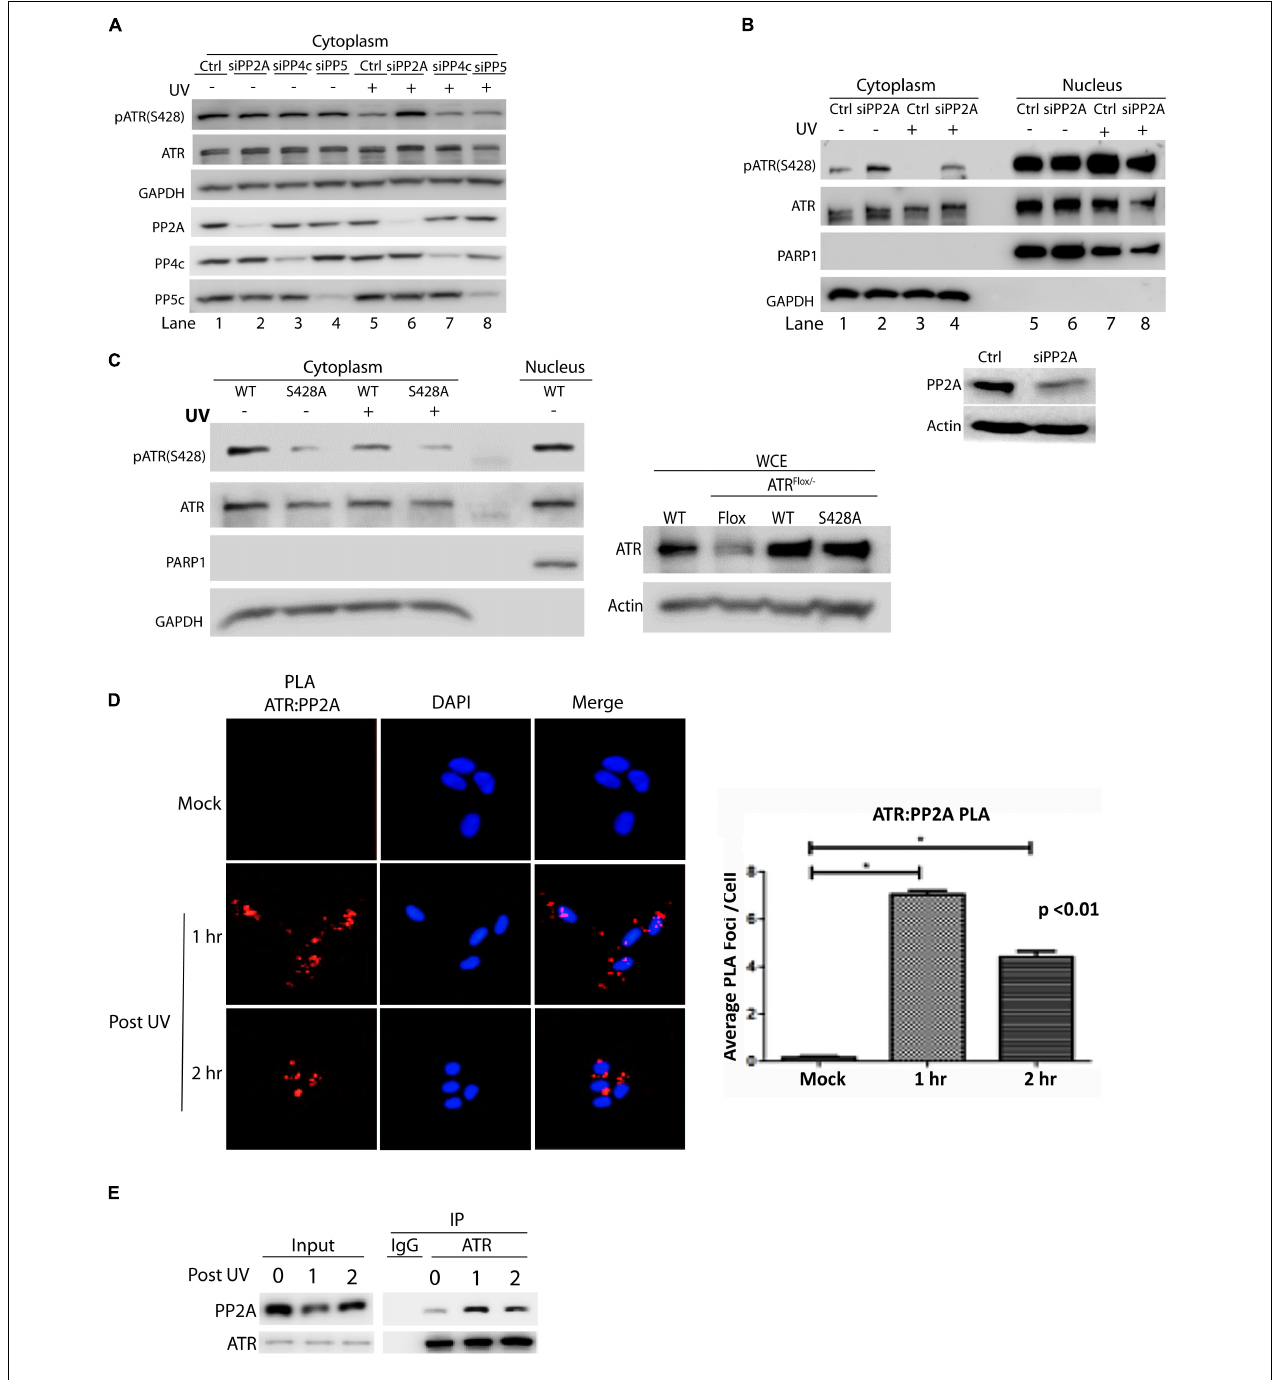
FIGURE 1 | Protein phosphatase 2A (PP2A) specifically dephosphorylates cytoplasmic ATR at S428 and its action involves direct binding to ATR. (A) A549 cells were treated with siRNAs against three protein phosphatases (PP2Ac, PP4c, and PP5c) followed by UV treatment at 40 J/m 2 with a 2 h recovery. Analysis of cytoplasmic extracts reveals that PP2A is required to dephosphorylate cytoplasmic pATR (S428). (B) siRNA knockdown of PP2Ac in A549 cells was followed by UV treatment at 40 J/m 2 with a 2 h recovery. pATR (S428) levels are increased in cytoplasm with PP2Ac knockdown while the phosphorylation status of ATR in the nucleus remains unchanged. WB of whole cell extracts shows PP2A siRNA knockdown efficiency in A549 cells (C) HCT 116 ATR flox / − cells were transfected with N-terminal Flag-tagged wild-type (WT) or S428A mutant ATR expression constructs and UV treated at 40 J/m 2 with a 2 h recovery. Analysis of the cytoplasmic extracts reveals that PP2A specifically targets the pATR (S428) residue. The pATR (S428) observed in the S428A cells reflects some phosphorylation of the residual endogenous ATR remaining in the ATR flox / − cells (right panel). (D) PLA revealing that in A549 cells there is a direct interaction between ATR and PP2A, especially after UV irradiation at 40 J/m 2 . A DAPI-staining overlay is used to show location of the nuclei. The bar graph represents a statistical analysis of the PLA images. (E) A549 cells treated with UV at 40 J/m 2 were lysed, followed by co-immunoprecipitation of PP2A using anti-ATR antibody. *Stands for p value < 0.01.